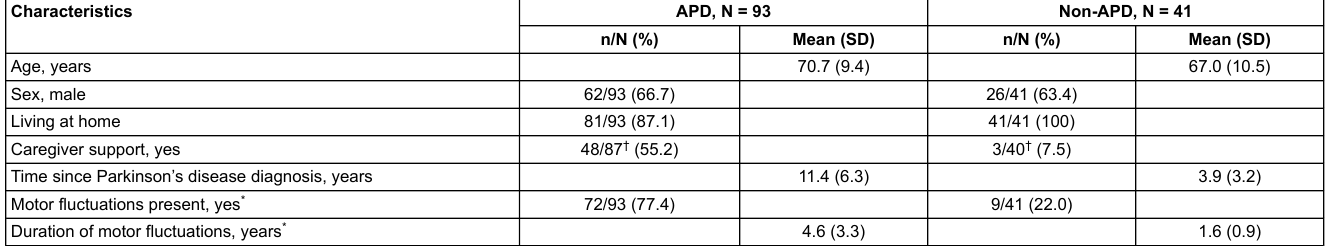
Table 2: Patient Characteristics of ADP and non-ADP based on physician’s judgement. Characteristics